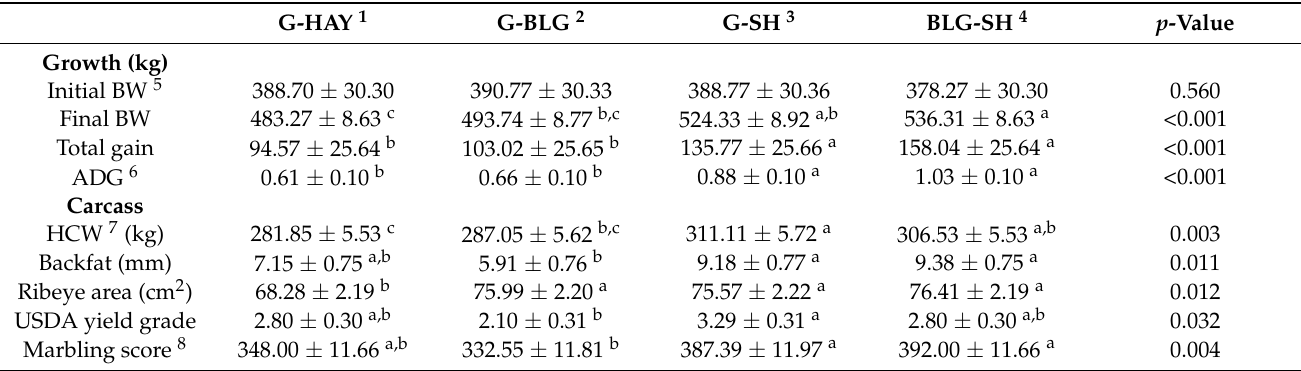
Table 3. Mean animal performance and carcass traits by diet.